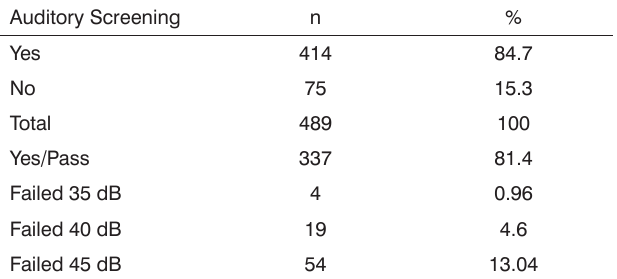
Table 1. Auditory screening results of the neonates in the CAISM neonatal ICU and intermediate care facility.